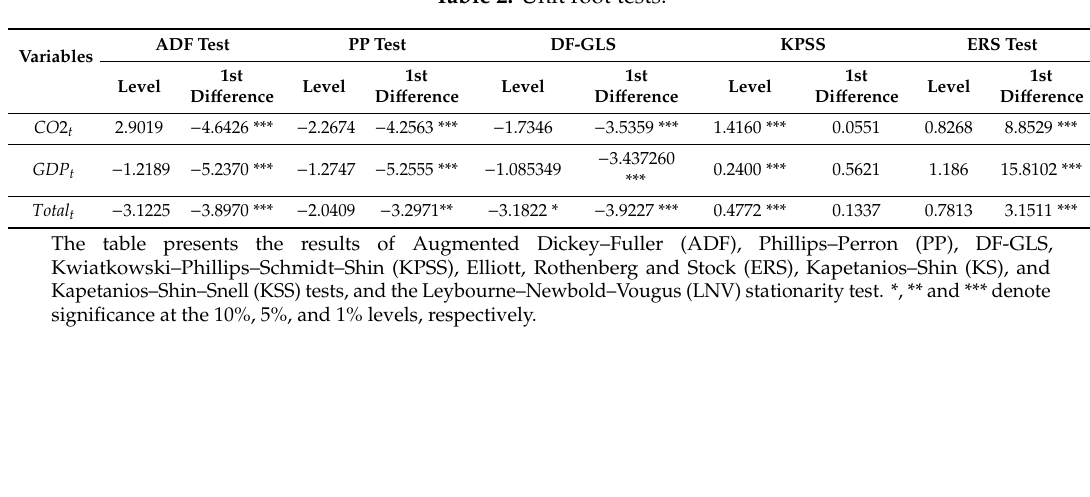
Table 2. Unit root